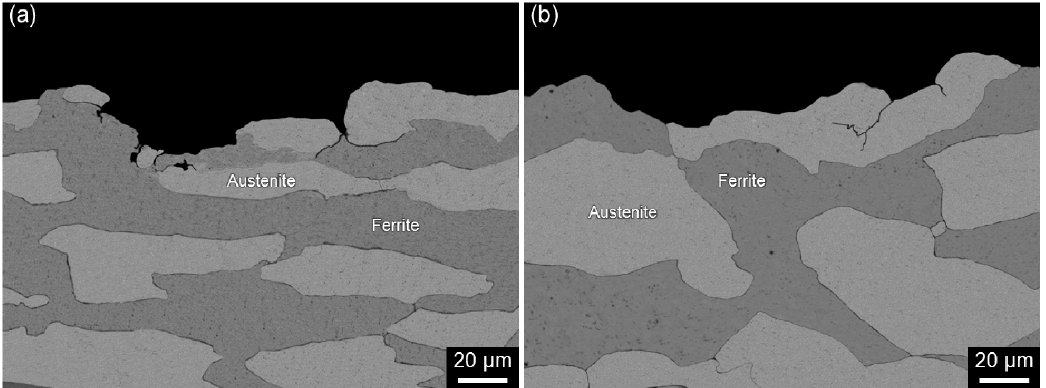
Figure 11. SEM micrographs of the cross-sectional view of ( a ) D1 and ( b ) D2 alloys after the SSRT conducted in 2 M NaCl solution at 50 °C under anodic applied potential of +0.05 V versus E corr at a strain rate of 10 − 6 s − 1 .